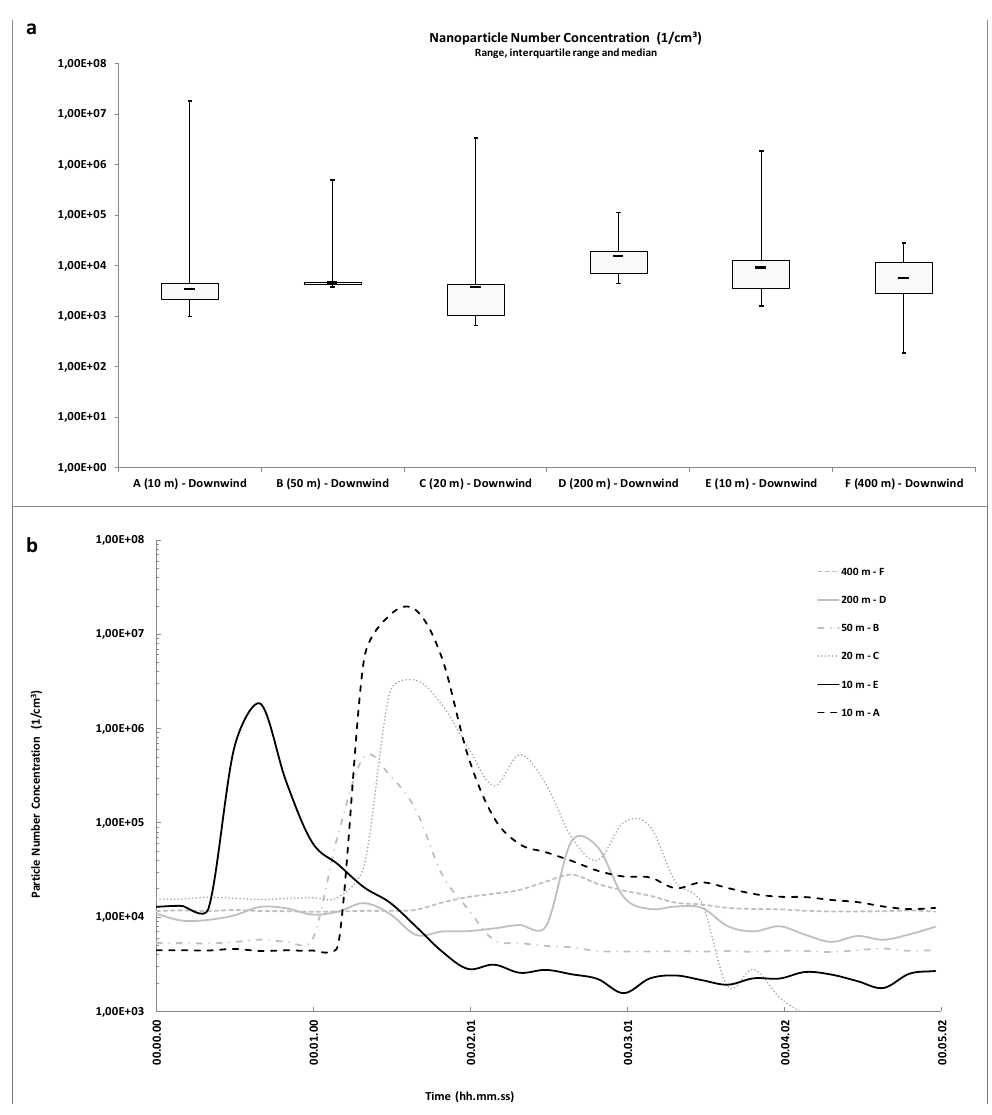
Figure 3. Ultrafine particle (UFP) count at the six sampling sites during inert bomb launch: ( a ) statistics represented through box plots; ( b ) total particle count versus time.